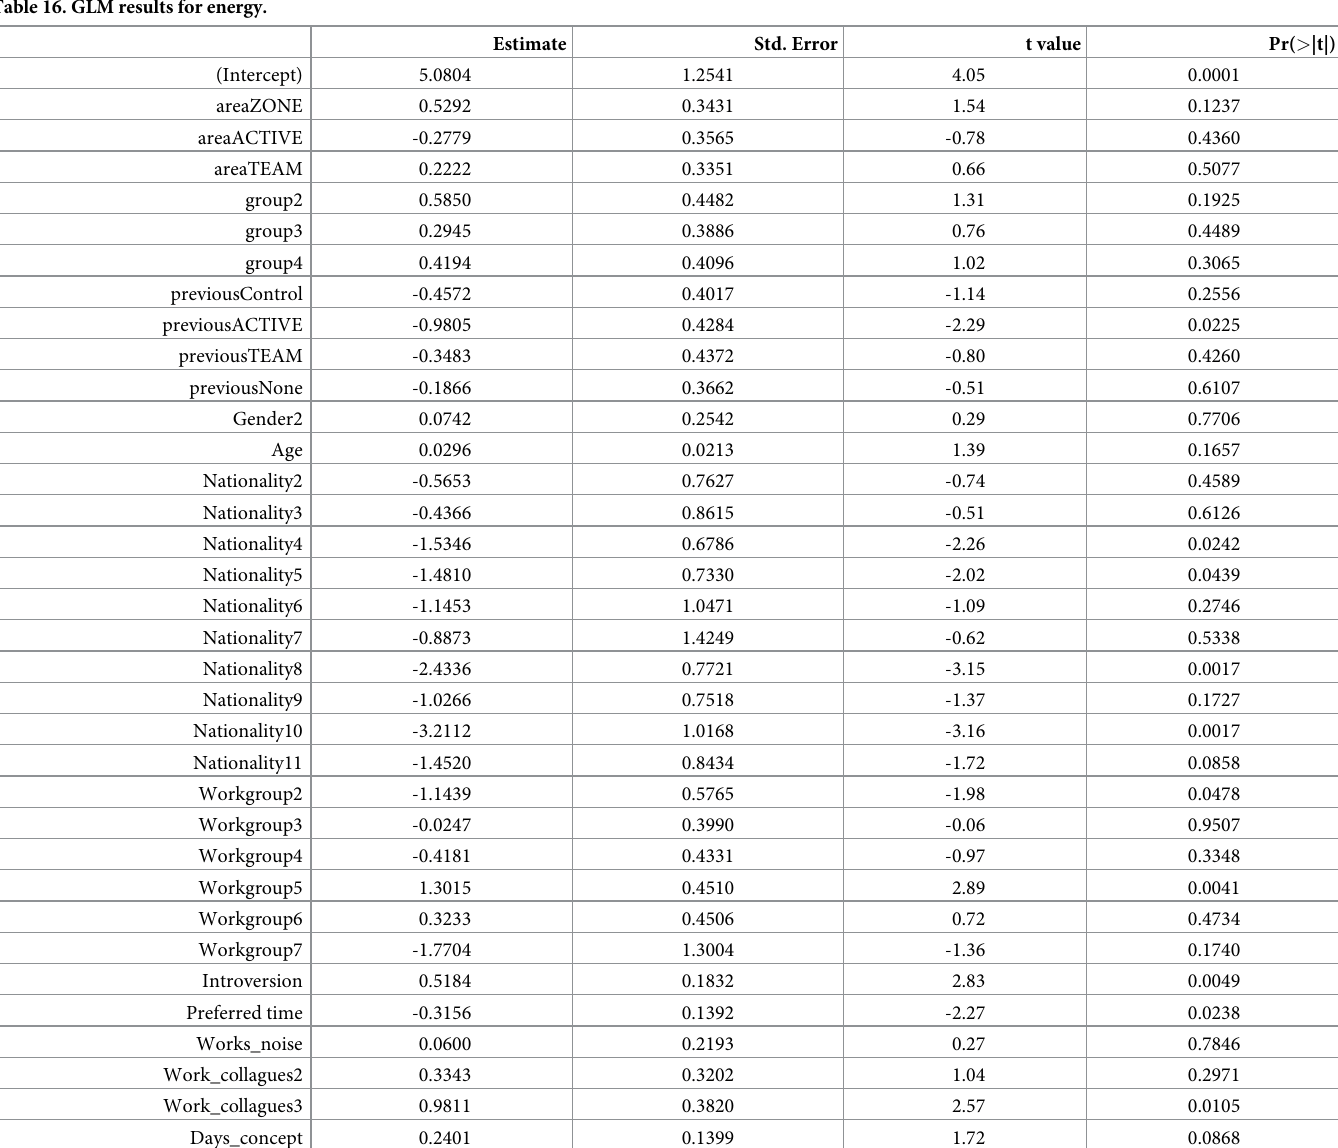
Table 16. GLM results for